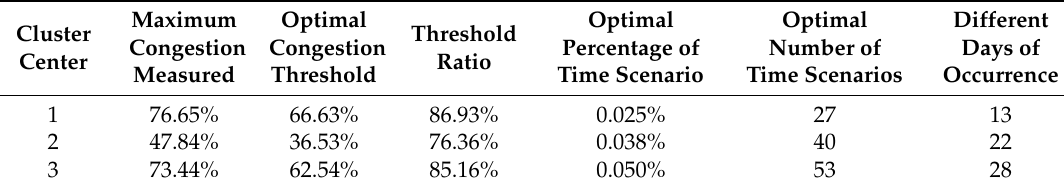
Table 8. Threshold ratios and time characteristics of the cluster centers.